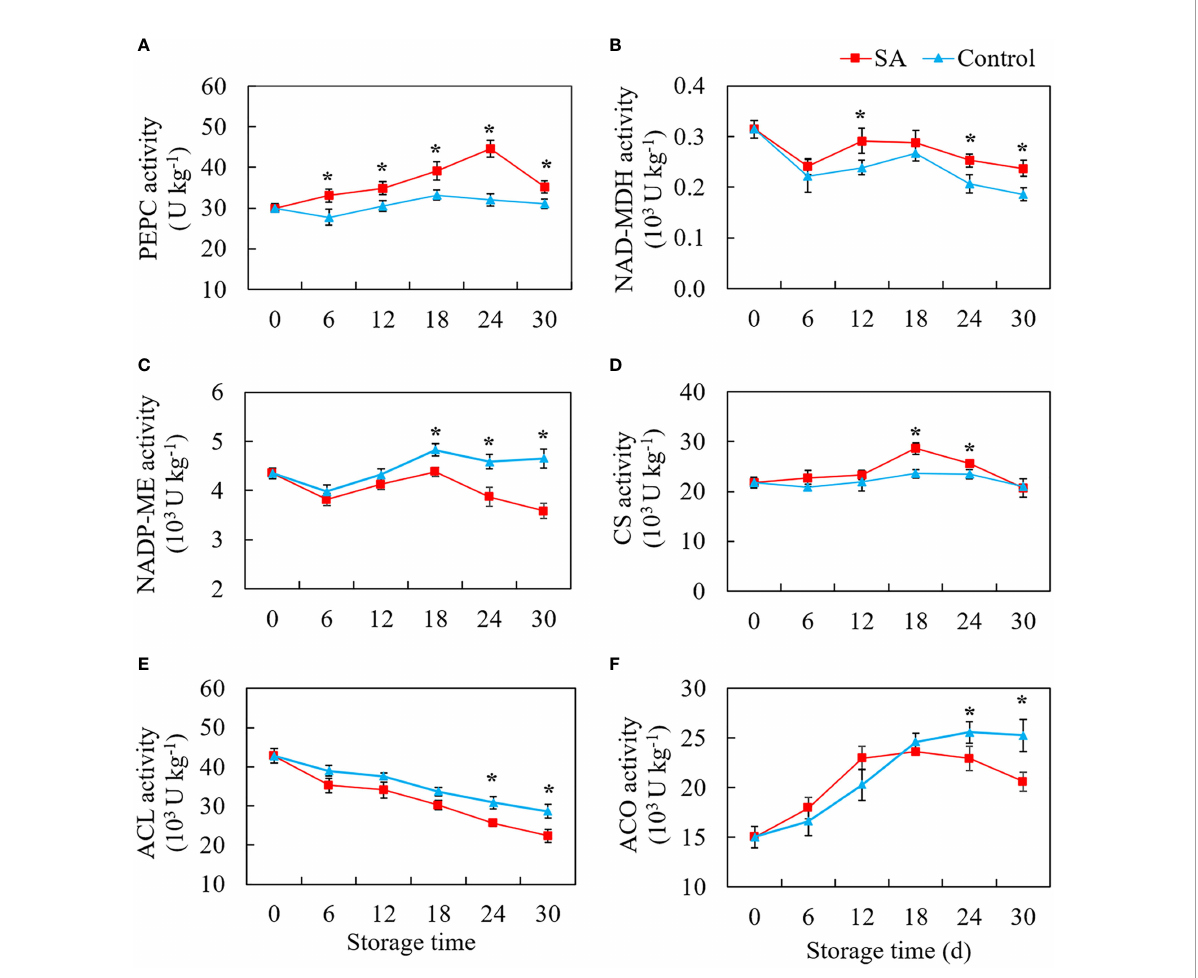
FIGURE 3 Effects of salicylic acid treatment on enzyme activities participated in organic acid metabolism of blueberry during cold storage. (A) , phosphoenolpyruvate carboxylase (PEPC); (B) , NAD-dependent malate dehydrogenase (NAD-MDH); (C) , NADP-dependent malic enzyme (NADP-ME); (D) , Citrate synthase (CS); (E) , ATP-citrate synthase (ACL); (F) , cytoplasm aconitase (ACO). Error bars represent the standard deviations of the means (n=3). The asterisks show a signi fi cant difference between SA-treated fruit and control fruit ( P <